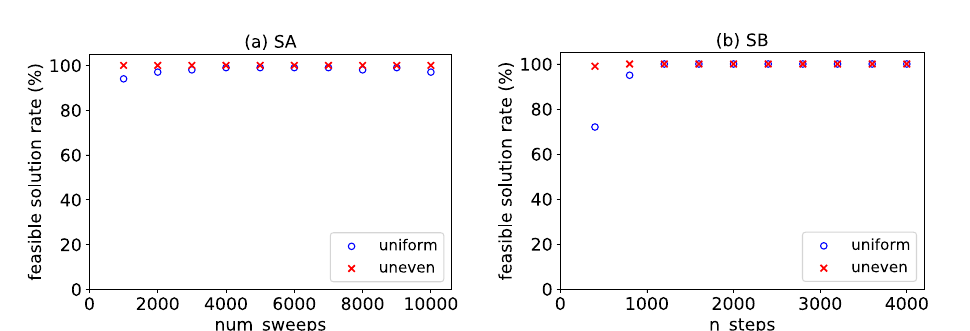
Figure 2. Feasible solution rates in ( a ) SA and ( b ) SB. The horizontal axis is the parameter representing the number of time steps: ( a ) the number of annealing steps, ( b ) the number of SB time steps. ◦ and × are for the data sets with uniform and uneven distributions,